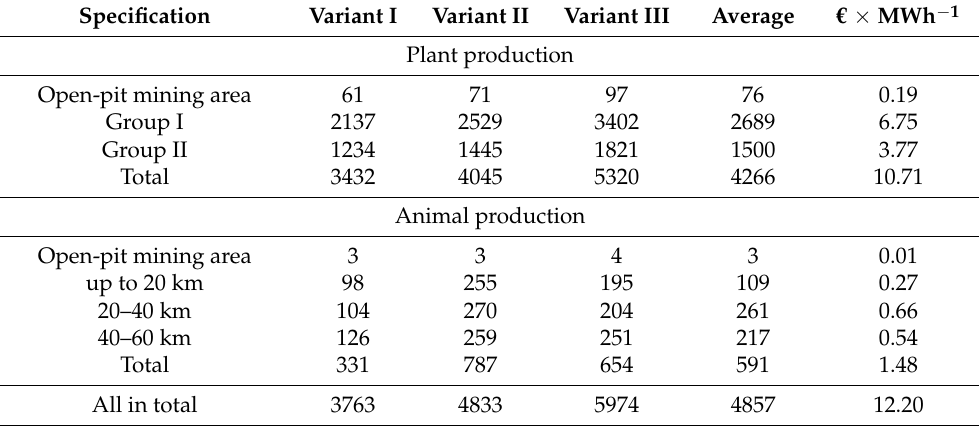
Table 8. External costs of exploitation of lignite from Złoczew deposit for 76 years of the impact of the opencast mine (million €